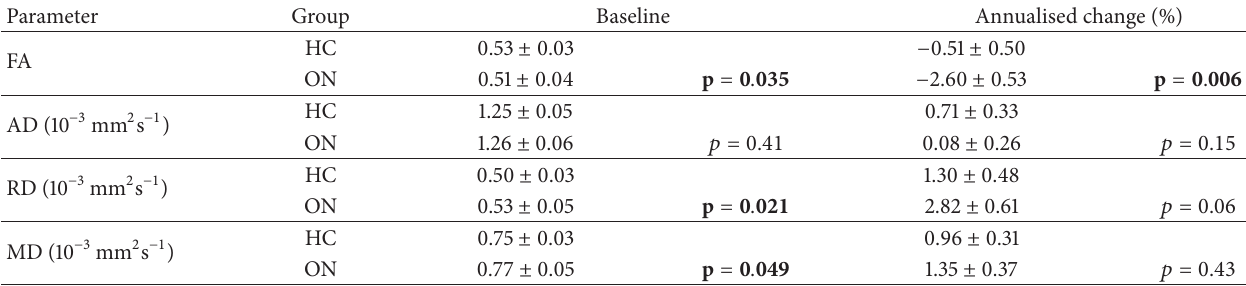
Table 3: Pearson 𝑅 coefficients and associated probability values for correlations between annualised rate of change in optic radiation DTI parameters and annual change in RNFLT, mfVEP, and primary visual cortex (V1) thickness and logarithmically transformed baseline lesion volume in the optic radiations (OR). For correlations with RNFLT and mfVEP change, only patients without OR lesions were included. For correlations with log OR lesion volume, only patients with OR lesions were included.